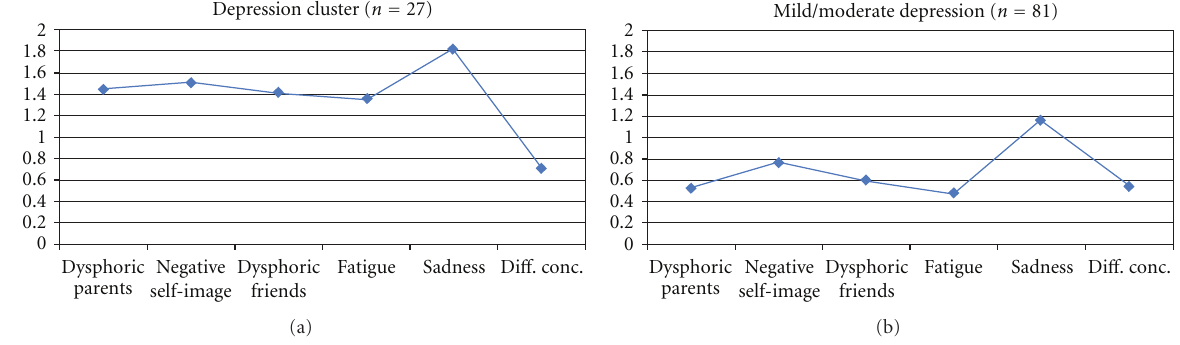
Figure 1: Depression-related clusters. Profiles in terms of z -scores (where z = 0 corresponds to the whole sample’s mean on each